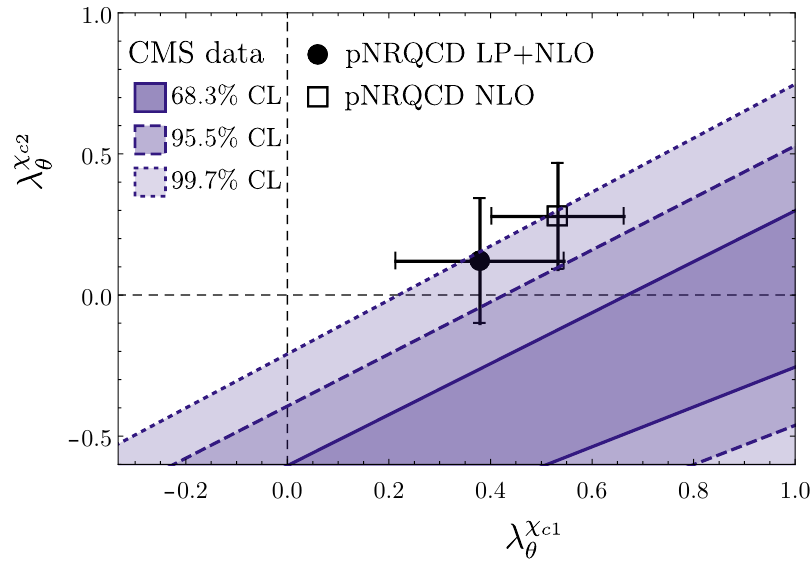
√ s = 7 TeV and < 30 GeV, compared with T